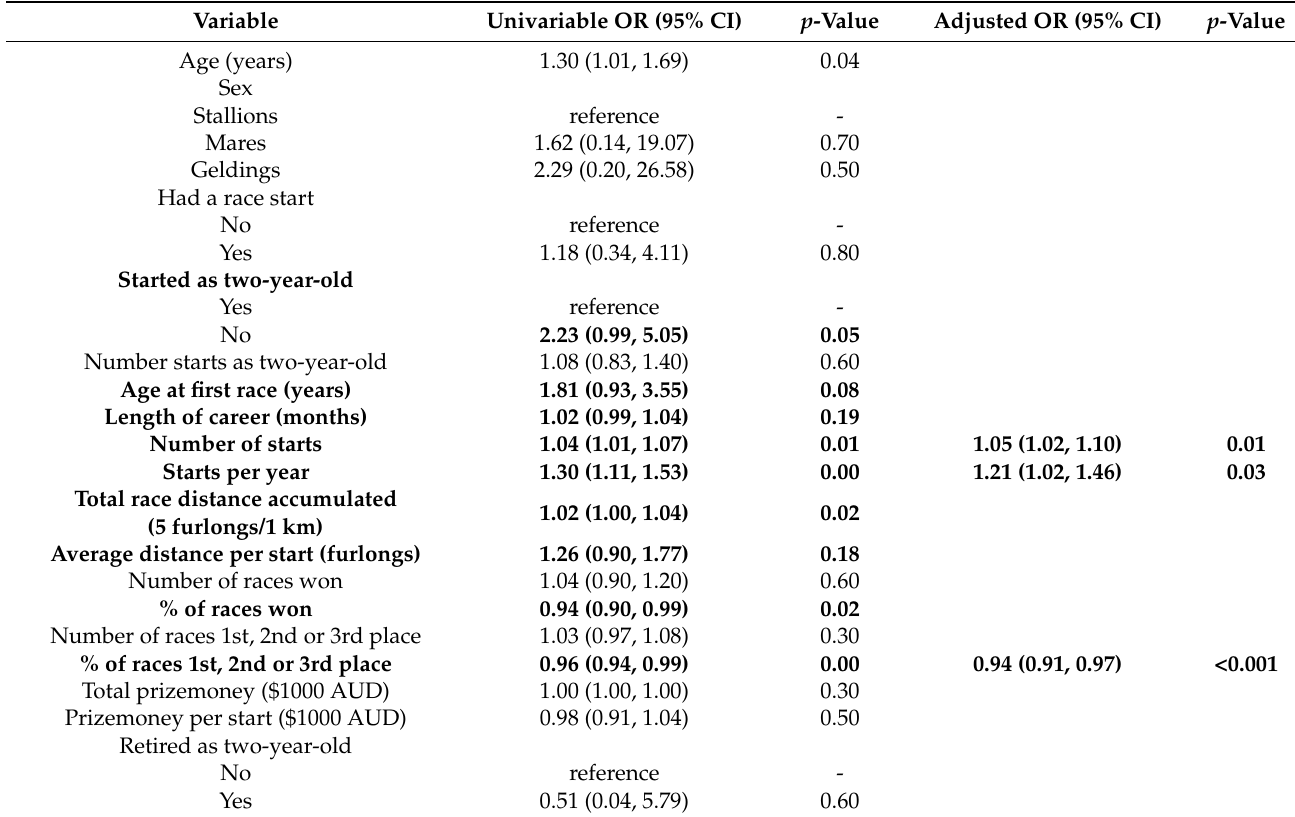
Table 5. The effect of population characteristics and the career racing and performance history on whether retirement was voluntary for 110 retired thoroughbred racehorses in South East